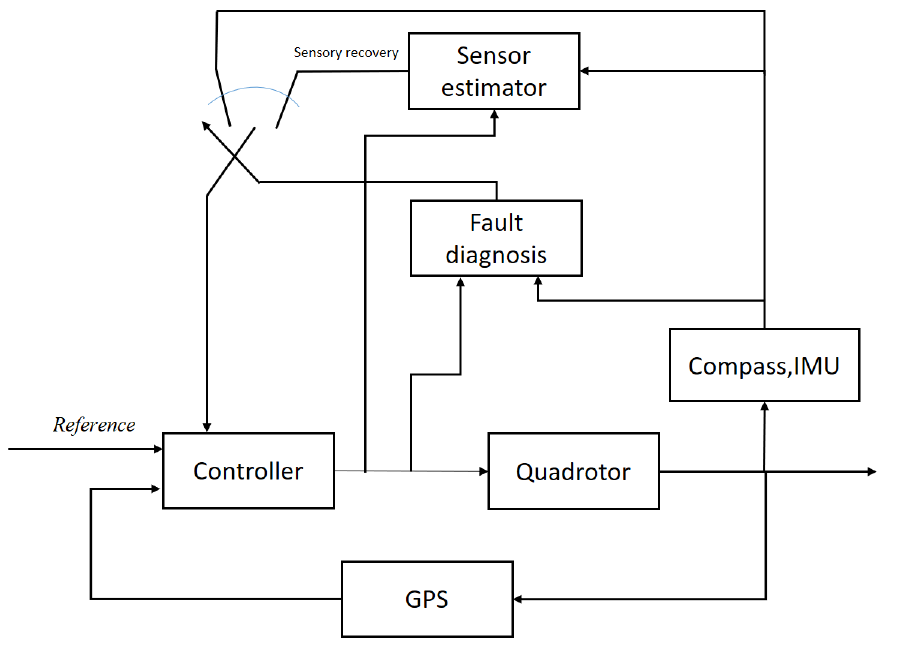
Figure 7. FTC against sensor fault with fault